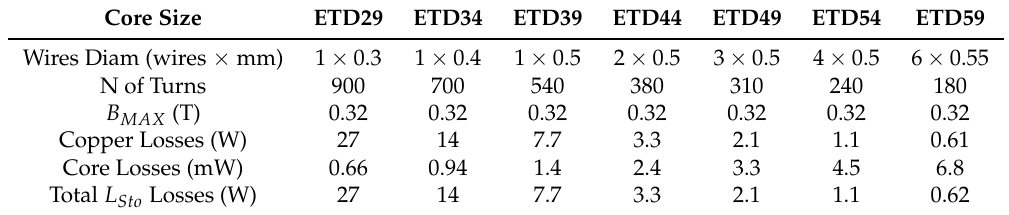
Table 4. Main Inductor Design Outputs for D = 0.2 ( L Sto = 12 mH).